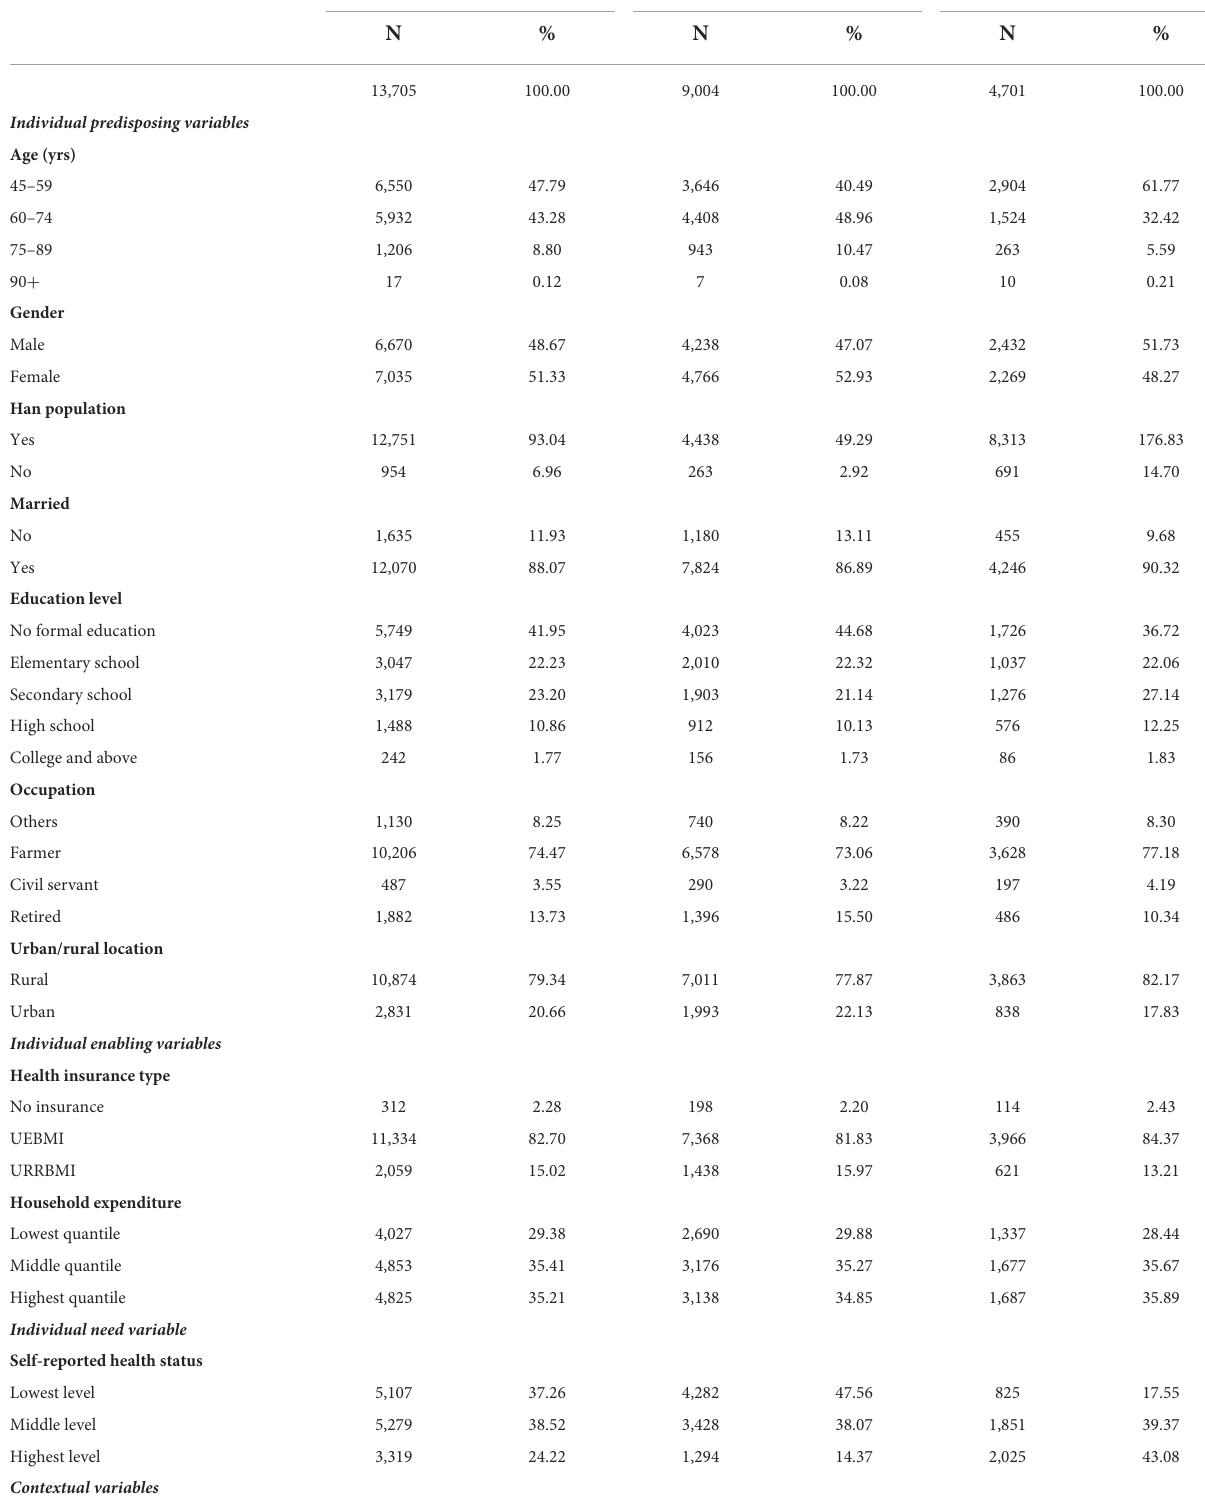
TABLE 1 Individual characteristics of the study sample from CHARLS after kernel matching. Total